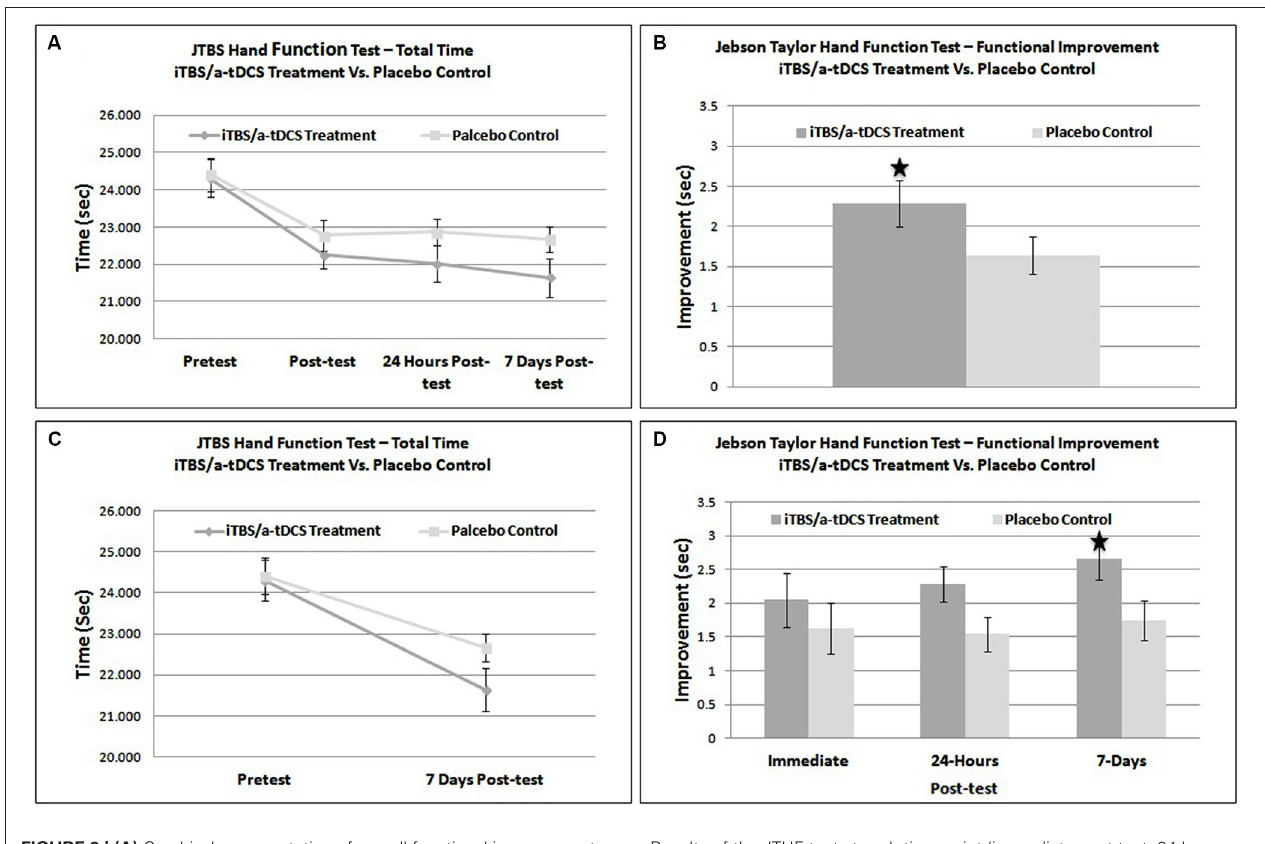
FIGURE 2 | (A) Graphical representation of overall functional improvement on the JTHF test. (B) Direct comparison of improvement (post-test − pre-test) on the JTHF test in sham and treatment groups. (C) Direct comparison of total performance time on the JTHF test in sham and stimulation groups. (D)